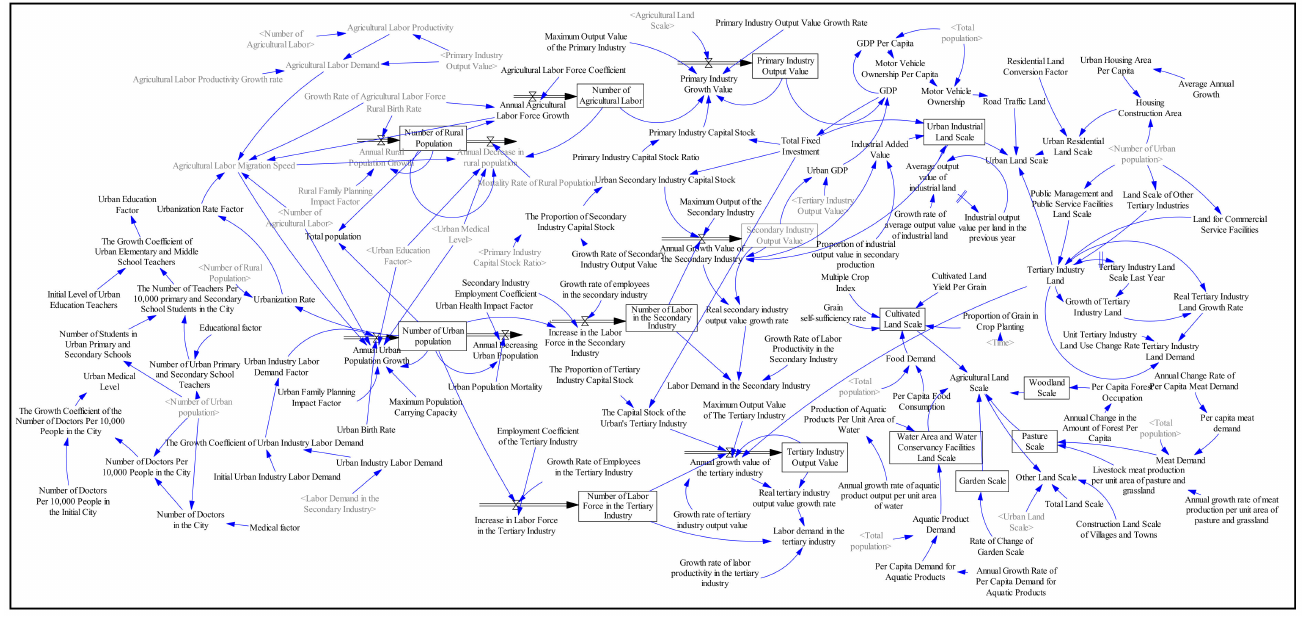
Figure 4. SD model of land use. Table 1. Model historical data simulation